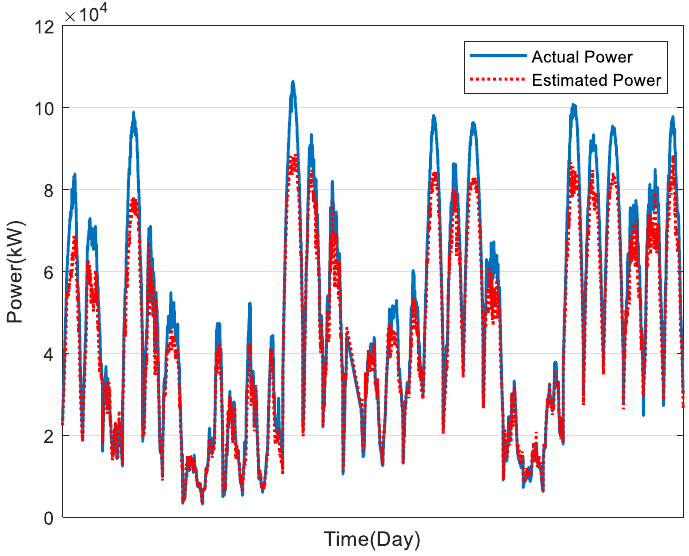
Figure 13. Results of PV power estimation in March.